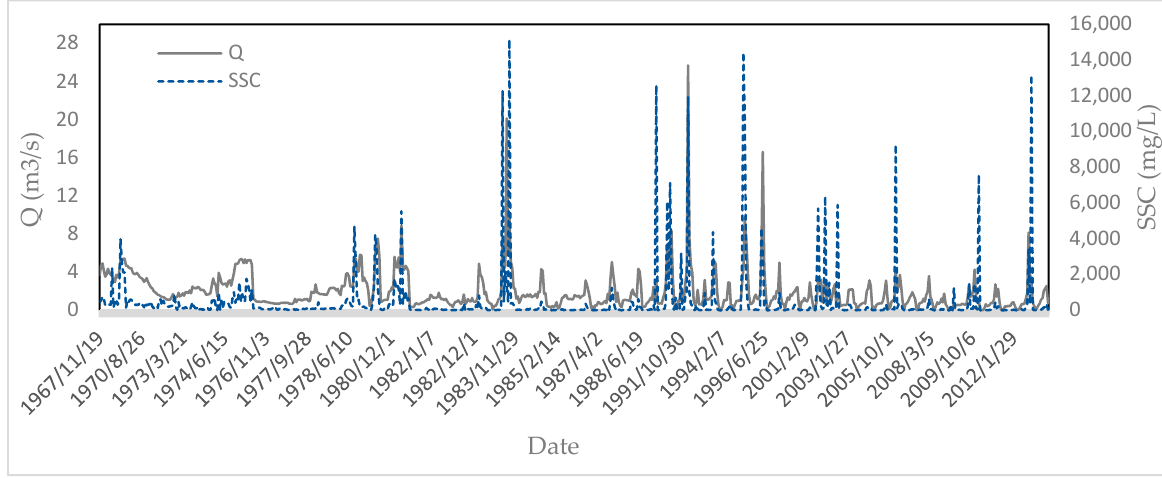
Figure 2. Time series graph for flow discharge and suspended sediment concentrations. Table 2. Statistical values of Q w in the training and testing datasets 2 .